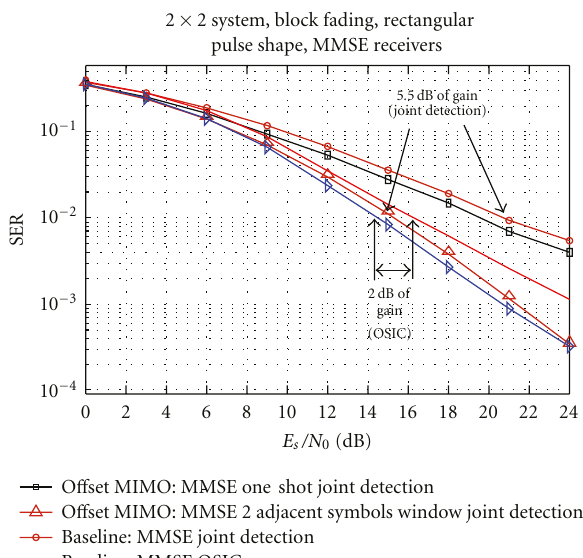
Figure 12: BER Performance for BPSK with various o ff sets, ( M T , M R ) =